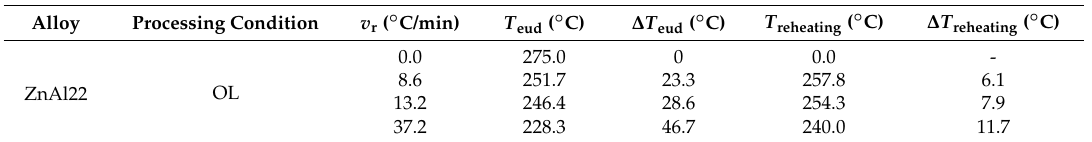
Table 5. Degree of overcooling and the recoalescence phenomenon registered for the different cooling rates.